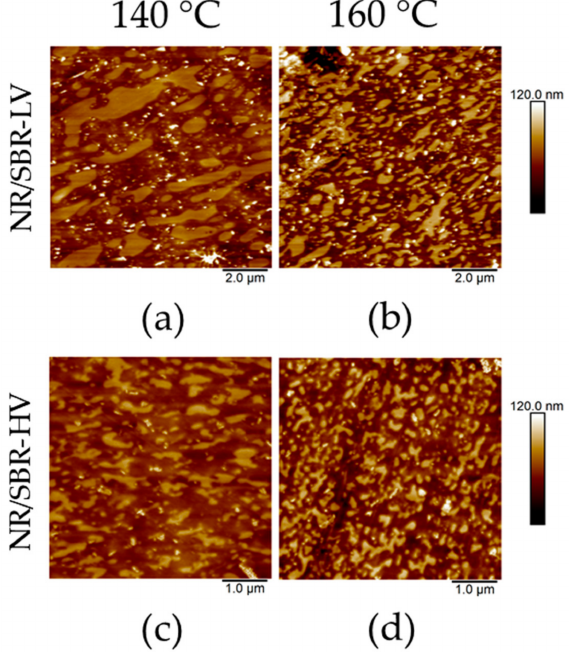
Figure 5. Comparison of topography images regarding the influence of curing temperature on blend morphology: NR/SBR–LV ( a ) at 140 ◦ C and ( b ) at 160 ◦ C; NR/SBR–HV ( c ) at 140 ◦ C and ( d ) at 160 ◦ C.